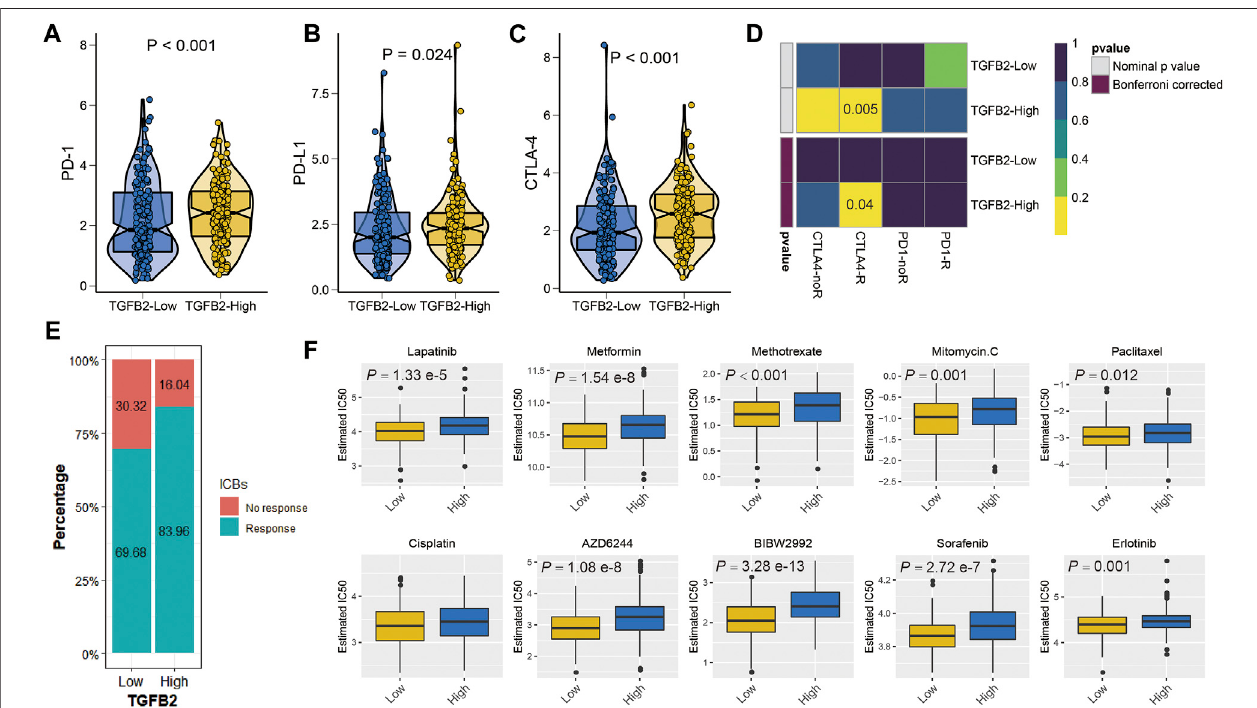
FIGURE 8 | TGF β 2 and immunotherapy and chemotherapy. Differences in immune checkpoints between high and low TGF β 2 groups, PD-1 (A) , PD-L1 (B) and CTLA-4 (C) . (D) Heatmap visualized the response to anti-CTLA4 and anti-PD1 therapies between the two groups. (E) The histogram showed the responsiveness of immunotherapy between high and lowTGF β 2 groups, theheight ofeach bar represents thefrequencyofchange. (F) Boxplotsdepicted thedifferencesinthe estimated IC50 levels of Lapatinib, Metformin, Methotrexate, Mitomycin. C, Paclitaxel, Cisplatin, AZD6244, BIBW2992, Sorafenib and Erlotinib between the high and low TGF β 2